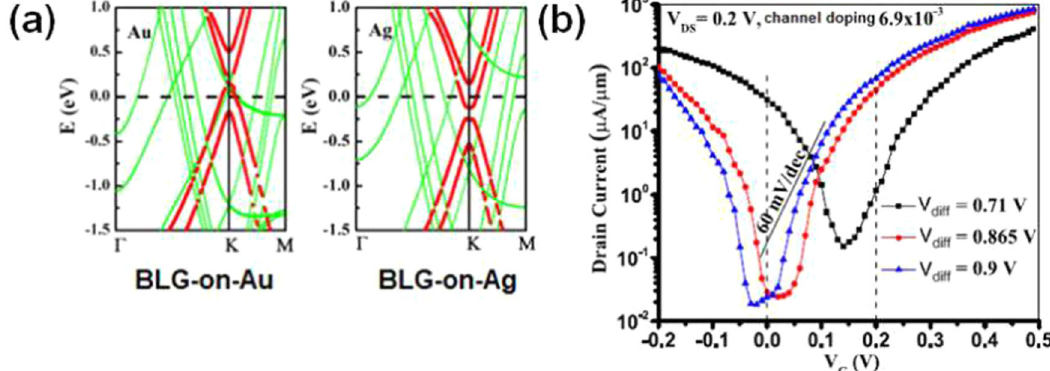
Fig. 6 Simulation Report of Nanoscale 2D GrNR-TFET. a Plots of E-k dispersion relation of 2L-Gr physisorbed on different metal substrates, adapted with permission from 172 . Copyright (2013) Nature, b transfer characteristics of asymmetrically doped 2L-Gr TFET, adapted with permission from 73 . Copyright (2014)